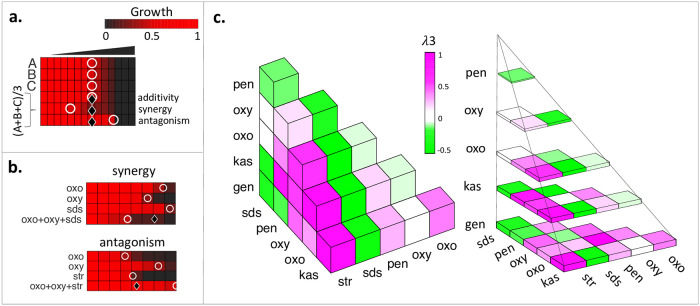
Measurement of all three-drug drug interactions among seven drugs in E. amylovora, using diagonal assays.(a) Similar to the diagonal assay for pairwise interactions, cells are grown in linearly increasing doses of three single drugs and one equipotent mixture of these three drugs. An expected IC50 is calculated using the IC50 of the individual drugs. If observed IC50 is smaller or larger than expected IC50, synergy or antagonism is concluded, respectively. (b) All three-way interactions are represented as 3D heatmap. Green, white or magenta boxes correspond to synergistic, additive or antagonistic three-drug drug combinations. On the right, the 3D heatmap is shown as layers to assist visualization.